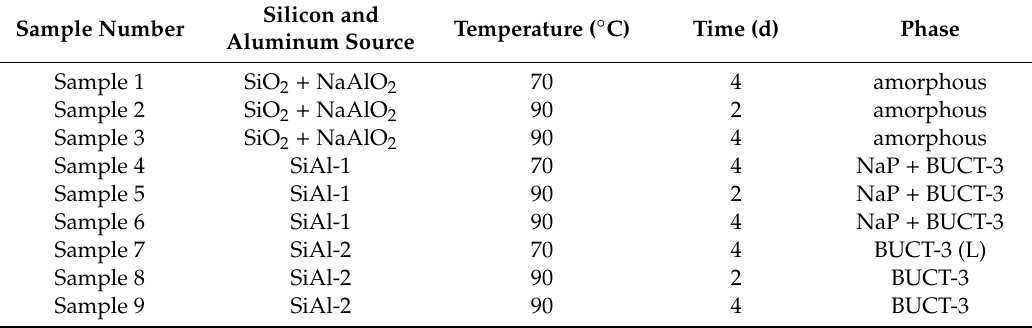
Table 2. The reaction conditions and the phases of Sample 1–9 (Al 2 O 3 :SiO 2 :TPAOH:H 2 O = 1:50:25:2500, 30 r /